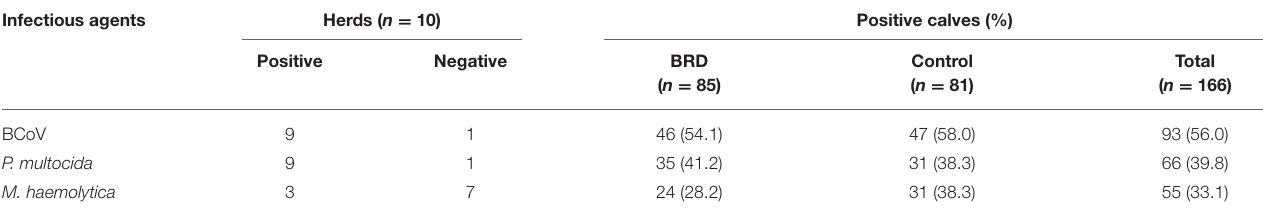
TABLE 2 | Infectious agents identified in the upper respiratory tract of heifer calves, with and without (controls) clinical respiratory signs, from high production dairy cattle herds. Infectious